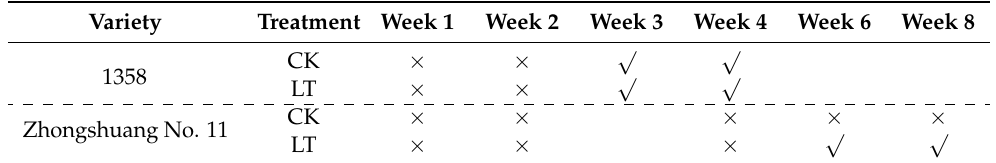
Table 1. Floral initiation time for spring and semi-winter rapeseed varieties “1358” and “Zhongshuang No. 11” under normal (CK) and low-temperature (LT) conditions. Variety